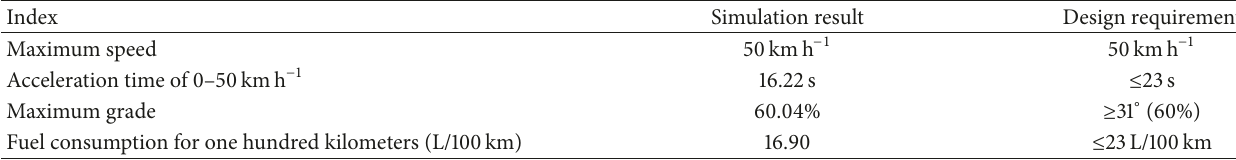
Table 6: Simulation result of dynamics.